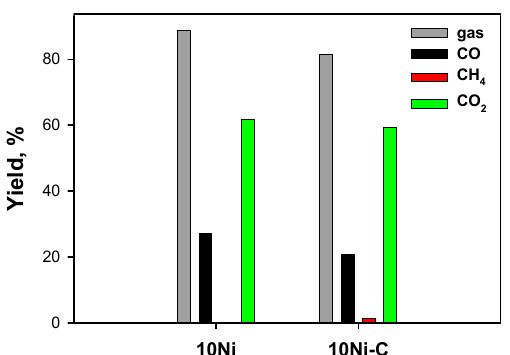
Figure 4. Gas yield and yields to CO, CH 4 , and CO 2 for 10 Ni and 10 Ni-C monoliths during steam reforming of the high-boiling-point stream (HB) mixture at 720 °C and atmospheric pressure; gas- phase feed composition: Solvent/H 2 O/O 2 /N 2 = 0.7/6/0.8/92.5.